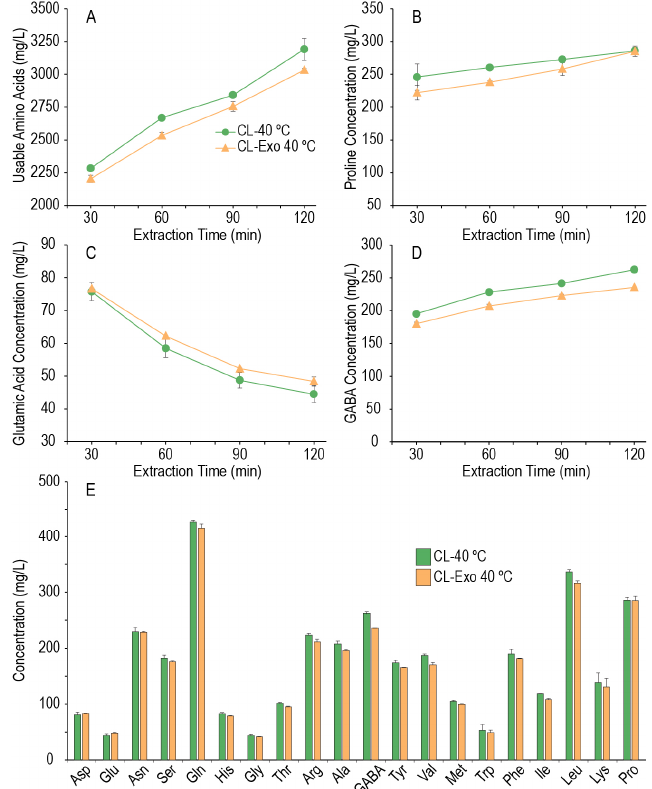
Figure 5. Sum of the usable amino acids, including GABA ( A ), proline concentration ( B ), glutamic acid concentration ( C ), and GABA concentration ( D ) across the extended enzyme extraction (L:G 3:1) at 40 °C. Amino acid profiles after 120 min at 40 °C ( E ). Glutamic acid was the only amino acid to decrease in concentration across this extended enzyme extraction.